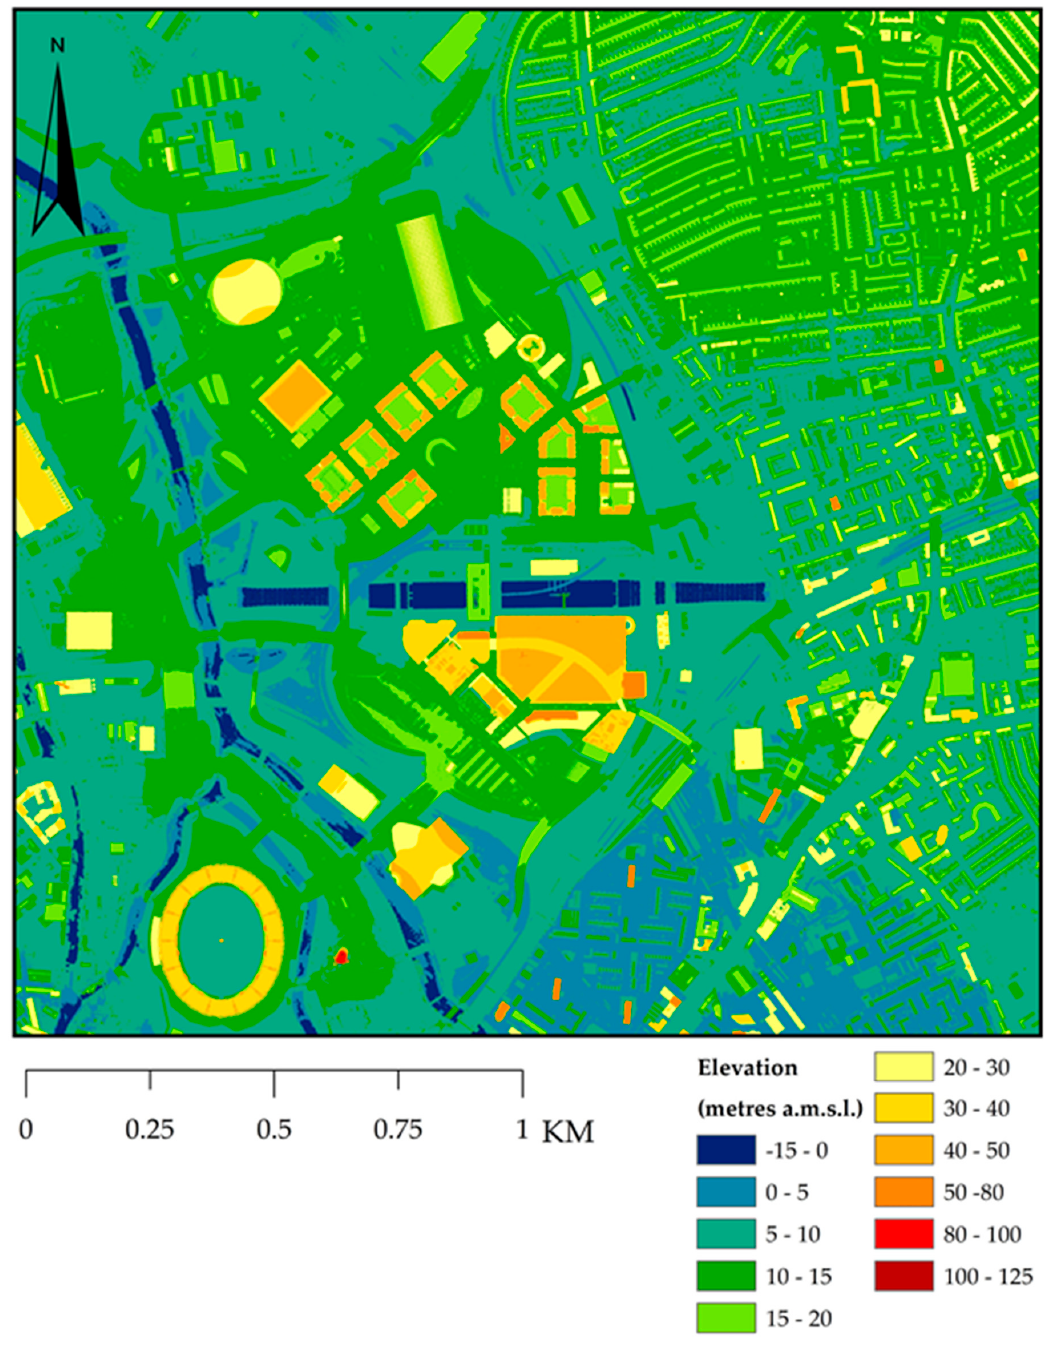
Figure 5. The 50 cm spatial resolution Digital Surface Model (DSM). Contains Ordnance Survey data © Crown Copyright and database right (2012). Contains Royal Mail data © Royal Mail copyright and database right (2012). Contains bathymetry data by GEBCO © Copyright (2012). Contains data by Land and Property Services (Northern Ireland) © Crown Copyright. Contains Lidar Composite Digital Surface Model England 50 cm resolution (ASC geospatial data), Scale 1:2000, Open Government Licence © Crown Copyright.